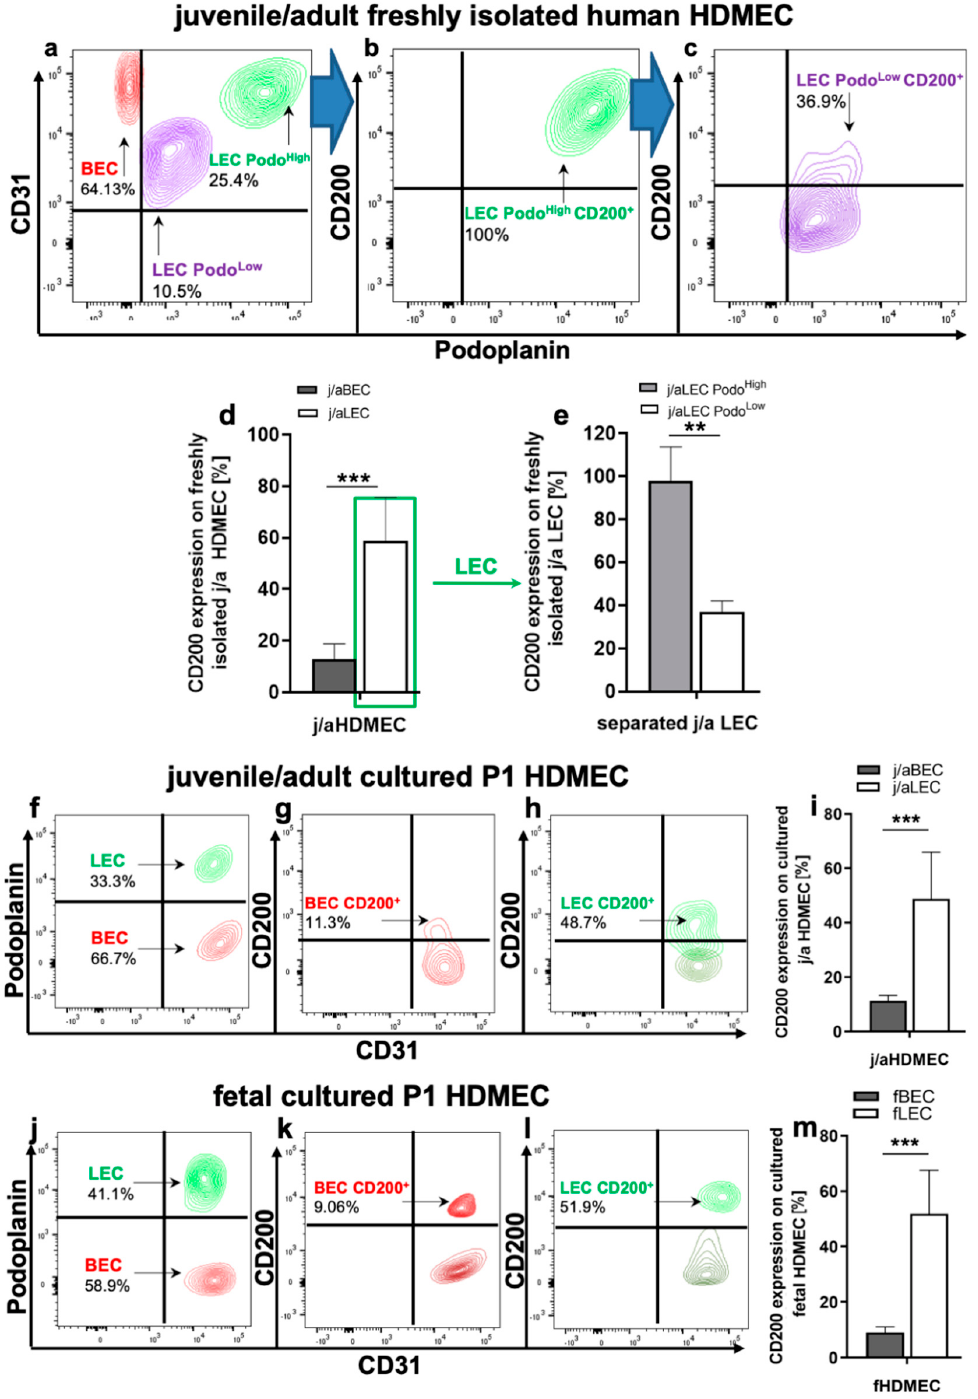
Figure 2. Expression of CD200 on freshly isolated as well as in vitro cultured juvenile/adult and fetal HDMEC. ( a ) Flow cytometry analysis of freshly isolated HDMEC derived from j/a human skin.